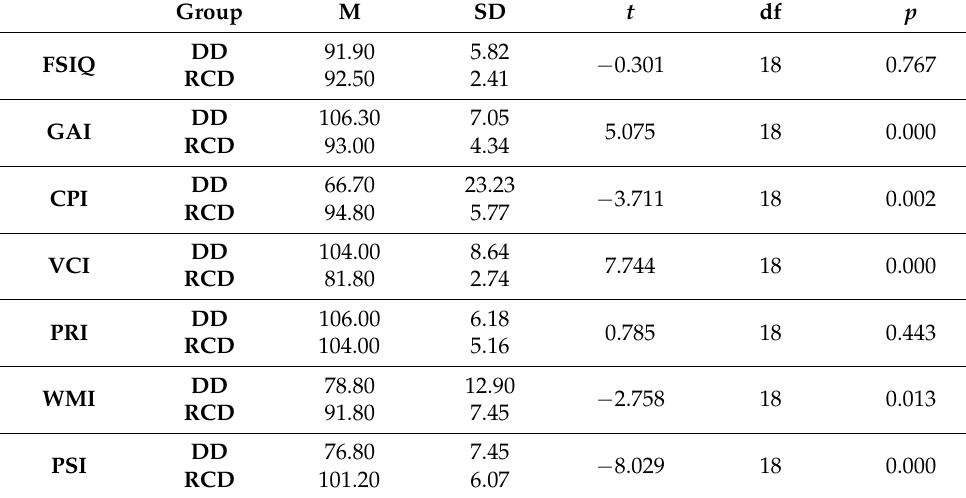
Table 1. Mean differences in WAIS-IV scale scores: comparison between